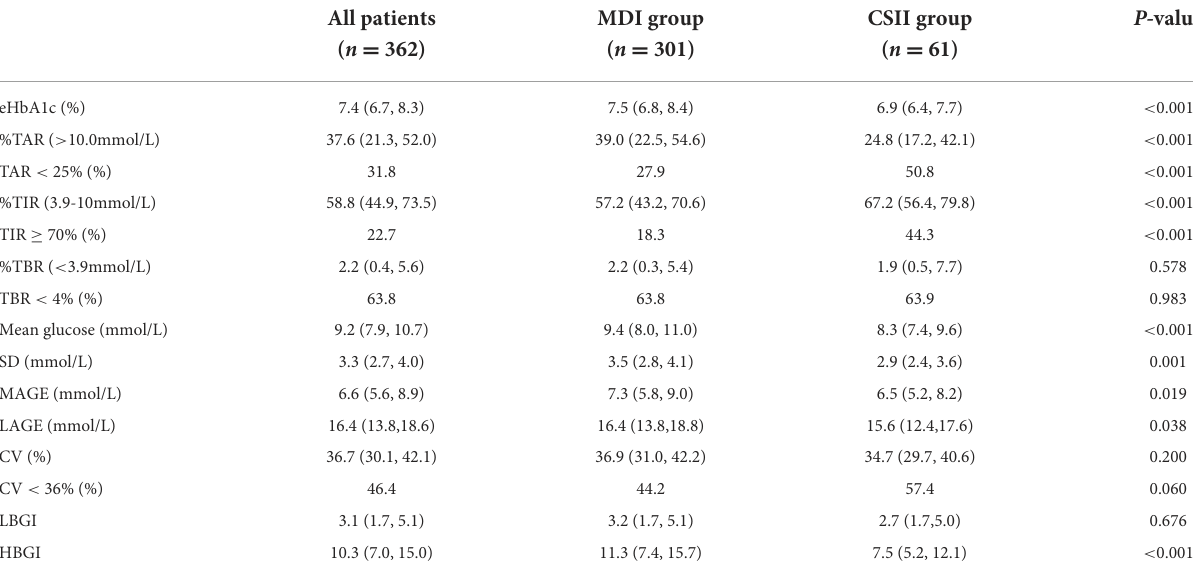
TABLE 2 Comparison of CGM-derived metrics between CSII and MDI groups. All patients MDI group CSII